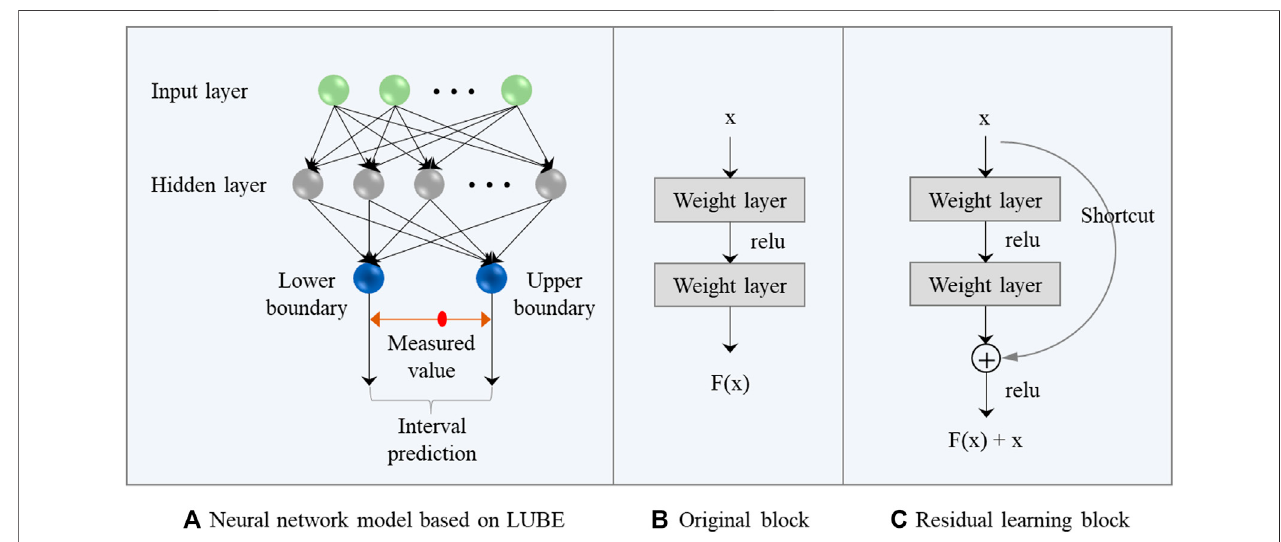
FIGURE 1 | Deep residual network integrated with LUBE